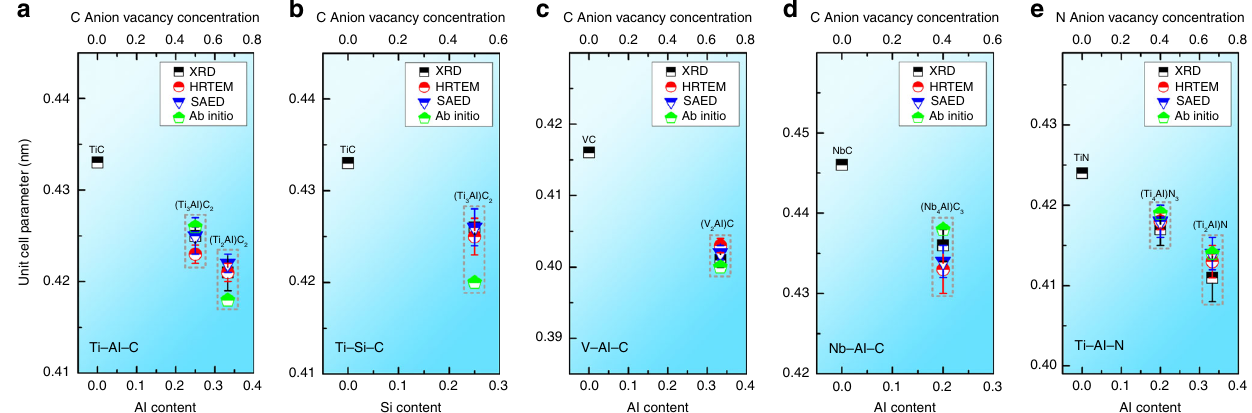
Fig. 5 Effect of A content and anion vacancy on unit cell parameter of the fcc-(M n + 1 A)X n solid solutions. Unit cell parameters of seven different fcc- (M n + 1 A)X n solid solutions, i.e., fcc-(Ti 3 Al)C 2 and fcc-(Ti 2 Al)C in Ti-Al-C system ( a ), fcc-(Ti 3 Si)C 2 in Ti-Si-C system ( b ), fcc-(V 2 Al)C in V-Al-C system ( c ), fcc-(Nb 4 Al)C 3 in Nb-Al-C system ( d ), and fcc-(Ti 4 Al)N 3 and fcc-(Ti 2 Al)N in Ti-Al-N system ( e ), compared to that of their corresponding binary MX compounds, respectively. The error bars represent the standard deviation of unit cell parameter determined from multiple measurements on samples under the same irradiation conditions. The experimental results and the calculation results agree well. The unit cell parameter in each system decreases with both A (Al or Si) content at the cation sites and X (C or N) vacancy concentration. Error bars represent the s.d. of multiple